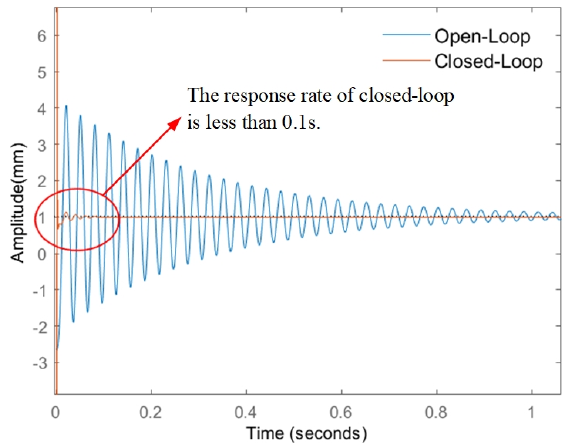
Figure 14. Response curve of open and closed loop systems.